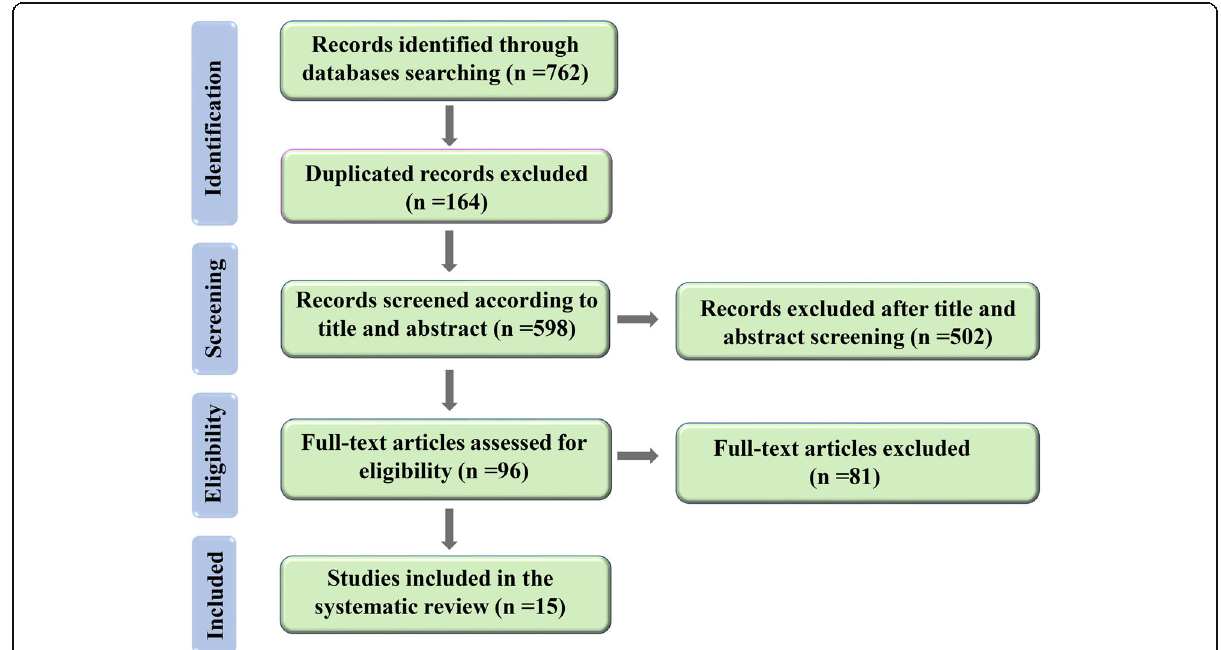
Fig. 1 PRISMA flowchart used for the study